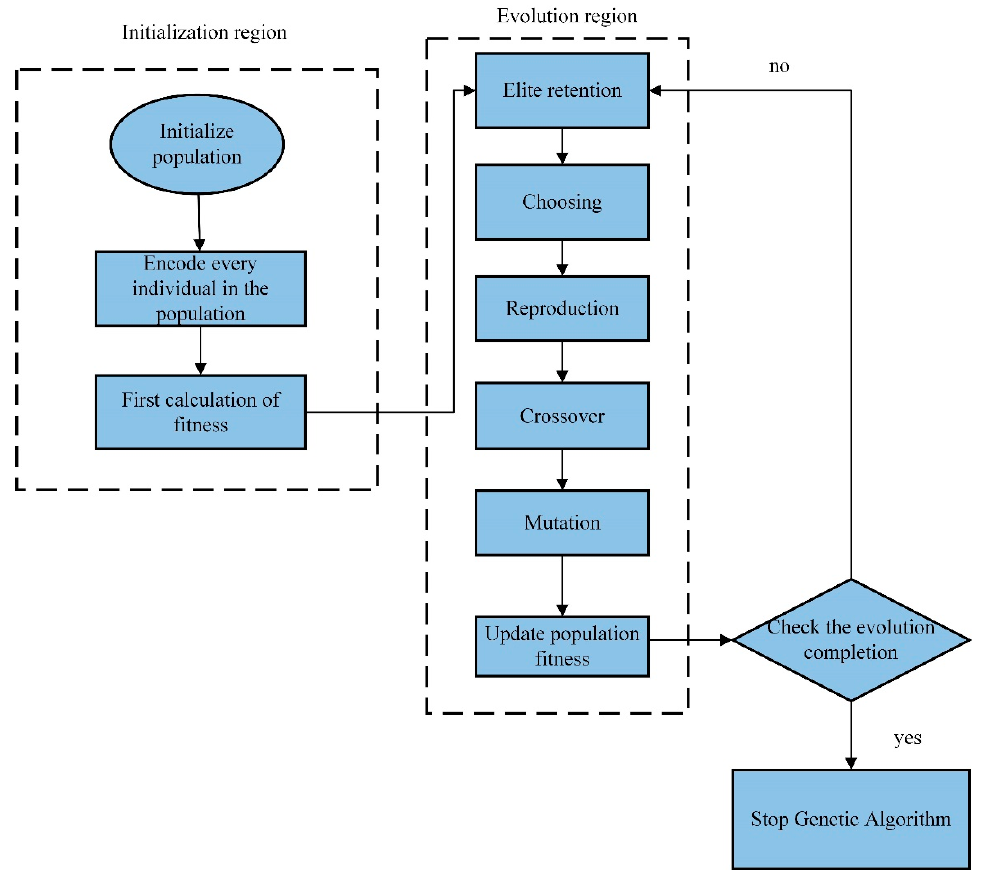
Figure 5. Sketch of the genetic algorithm process.